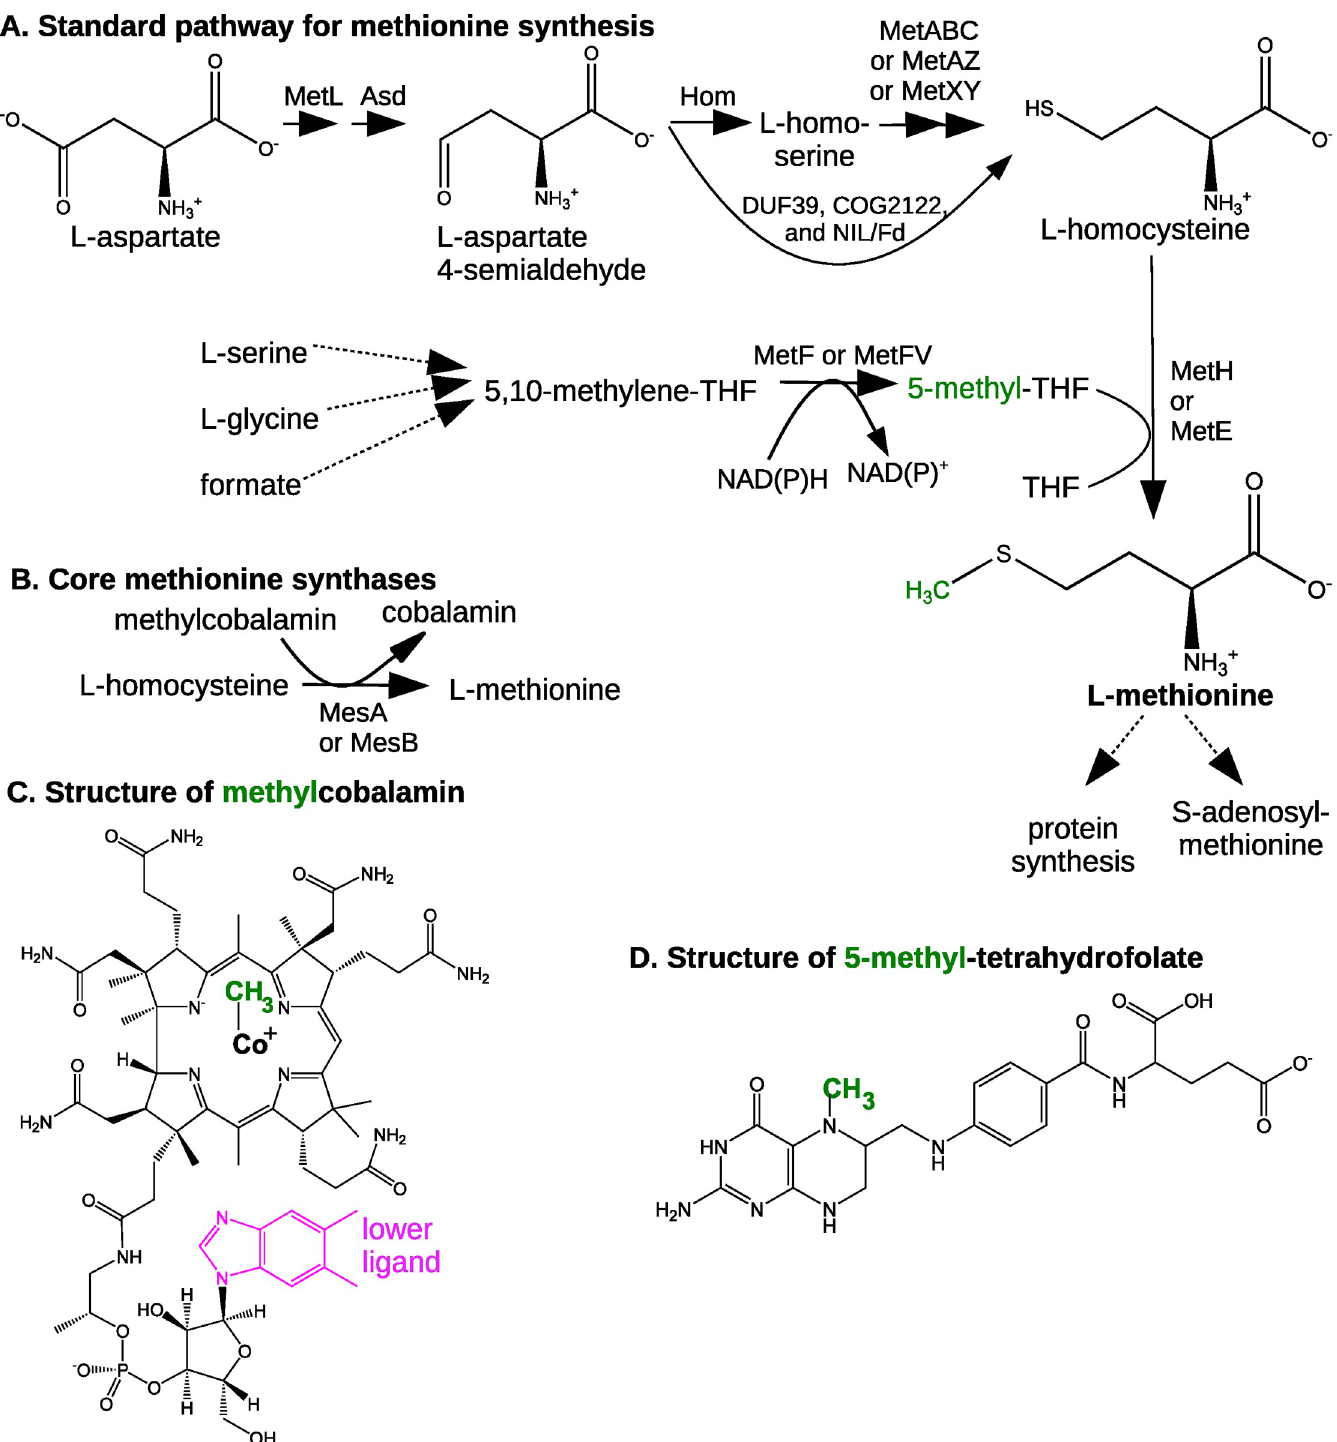
Fig 1. Overview of methionine synthesis. (A) The standard pathway with 5-methyl-THF. (B) The reaction catalyzed by the core methionine synthases MesA and MesB. (C) The structure of methylcobalamin. Cobalamin has 5,6-dimethylbenzimidazole as the lower ligand, but many organisms use cobamides with other lower ligands. (D) The structure of 5-methyl-THF. Although THF is shown with a single glutamyl residue (at right), in the cell, THF is usually polyglutamylated.